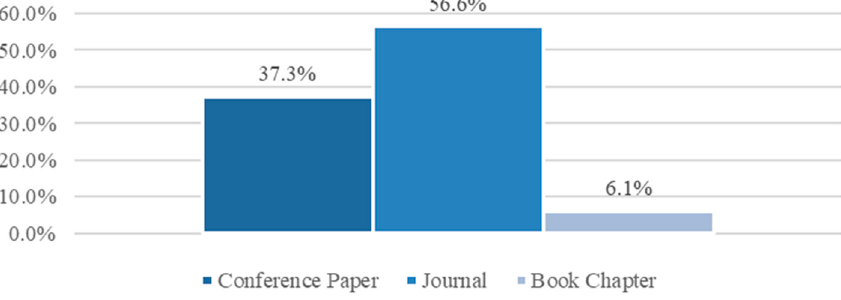
Figure 4. Study types as percentages.